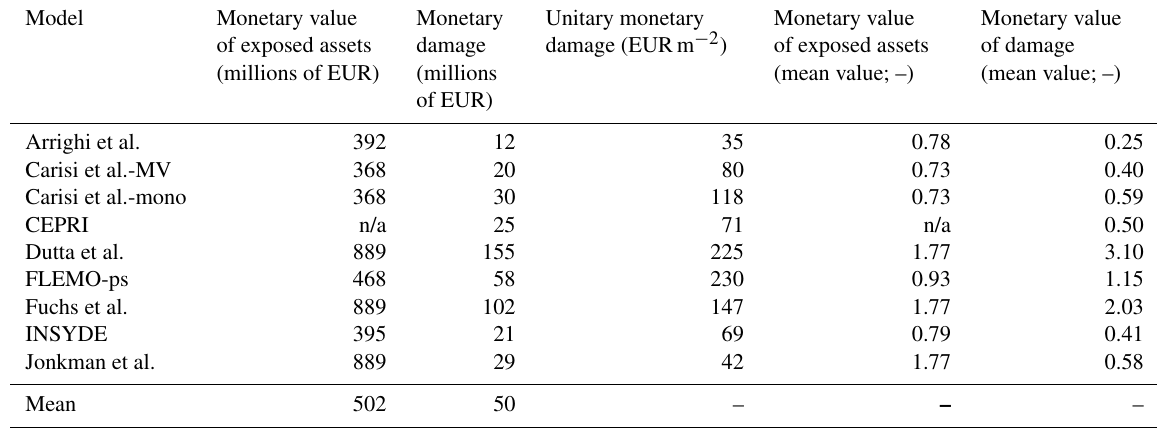
Table 3. Estimates of the monetary value of exposed assets and damage for all the buildings in the flooded area. The first column reports the total value of exposed assets (n/a: not applicable). The second and the third columns report, respectively, the total damage and the unit damage per square meter. The fourth and the fifth columns report the ratio between estimates and mean value of estimates (reported in the last row) for exposed assets and damage, respectively.